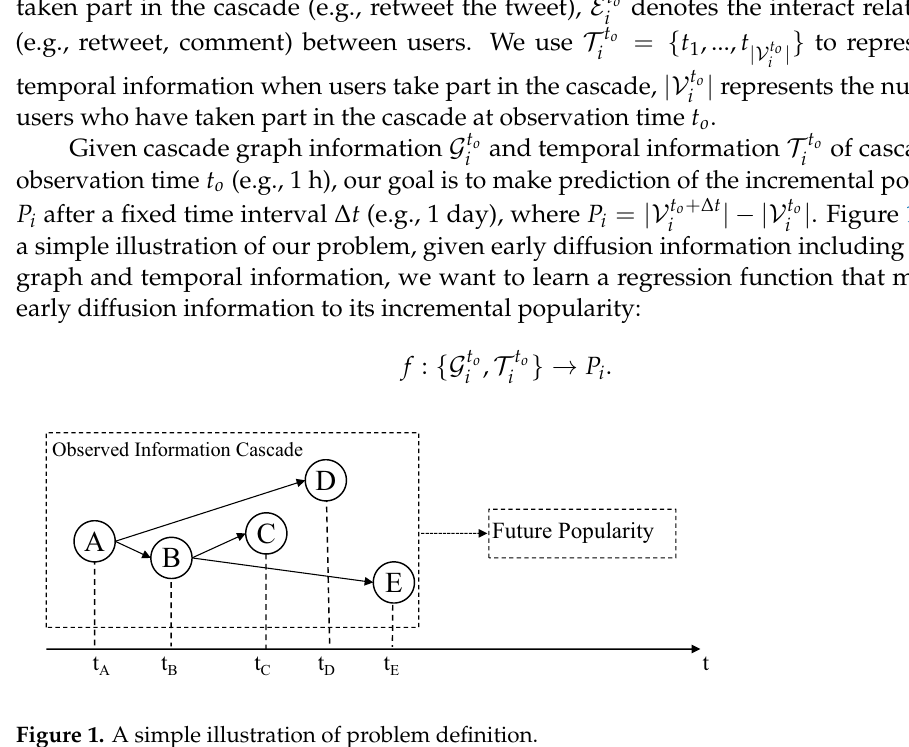
Figure 1. A simple illustration of problem